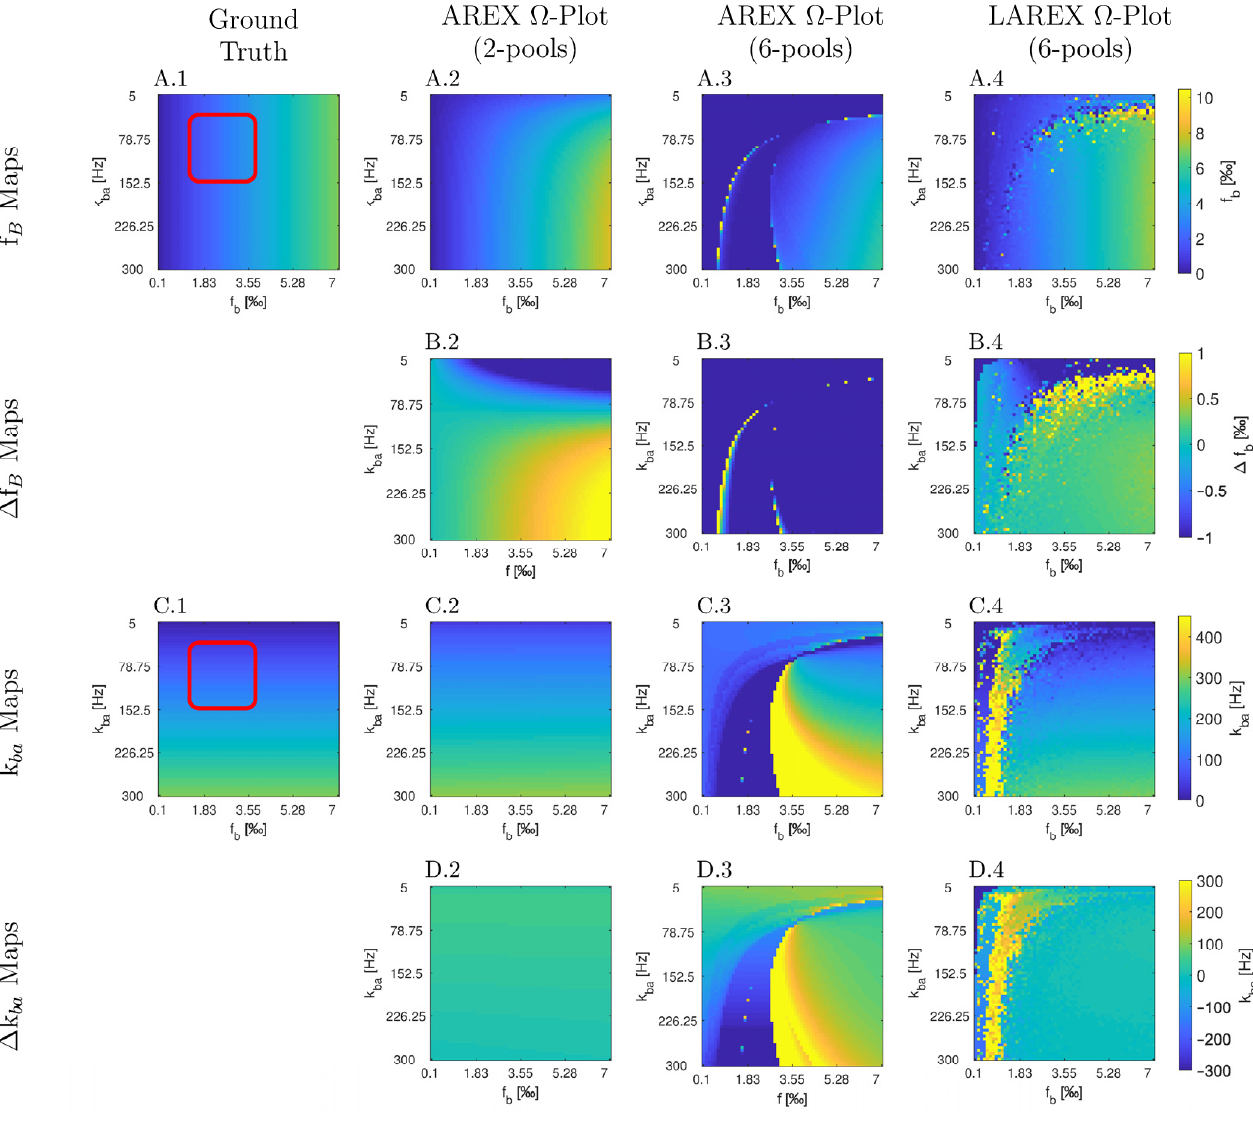
Figure A1. In silico Appendix Study 1—APT qCEST analyses of white matter of the visual cortex. Parameter maps ( A , C ) and color-coded error maps ( B , D ) for fractional APT concentrations f b and exchange rates k ba as a function of f b and k ba . The study was performed using a 4-pool system and a field strength of 7 Tesla. The parameters of the exchanging proton pools were: Water (T 1 = 1200 ms, T 2 = 40 ms, and ∆ = 0 ppm); APT (T 1 = 1000 ms, T 2 = 10 ms, f = variable between 0.001–0.2, k ba = variable between 1–300 Hz, and ∆ = 3.5); NOE (T 1 = 1000 ms, T 2 = 0.3 ms, f s = 0.06, k ba = 10 Hz, and ∆ s = − 3.5 ppm); MT (T 1 = 1000 ms, T 2 = 10 µ s, f s = 0.11, k ba = 50 Hz, and ∆ s = 0 ppm), and were based on the results of Mougin et al. [67]. Furthermore, analogous to the in silico, in situ, and in vivo experiments, the same MR parameters (TR = 2500 ms, TE = 3.5 ms) and presaturation parameters (n p = 40, t p = 100 ms, t d = 100 ms, presaturation pulse shape = Gaussian, ∆ ω = 5 ppm) were